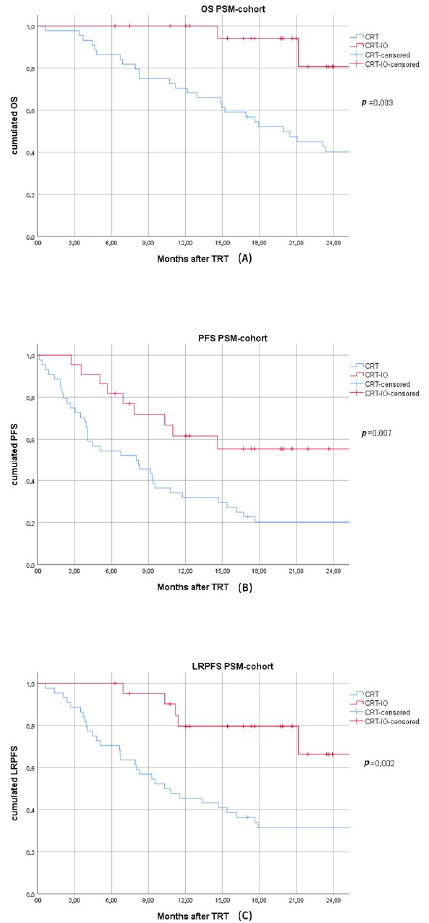
2 Figure 2. ( A ). Kaplan–Meier curve of the PSM-subgroups for overall survival (OS) of